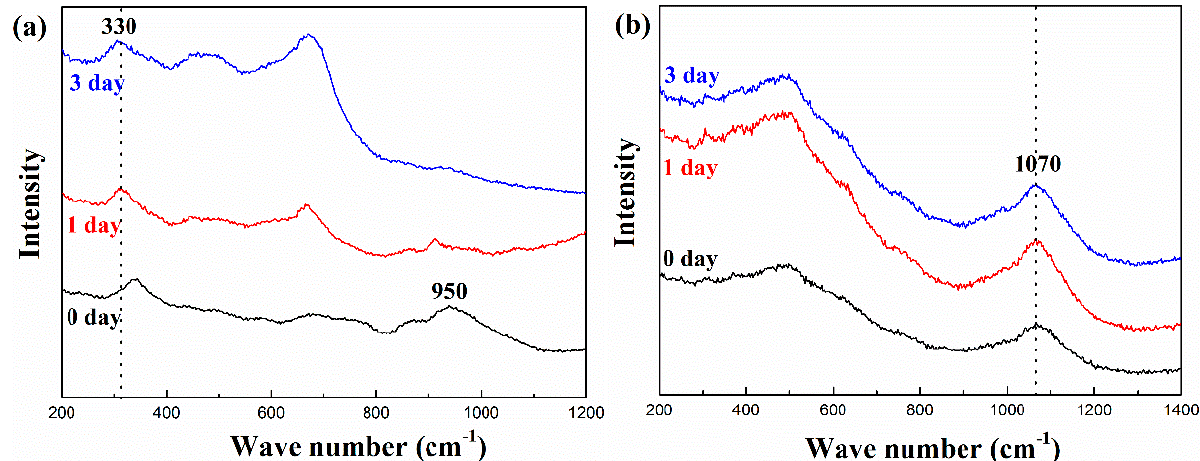
Figure 11. Raman spectra of the LS ( a ) and the HS ( b ) before and after corrosion for different days in the 0.5 M HCl solution at 30 °C.